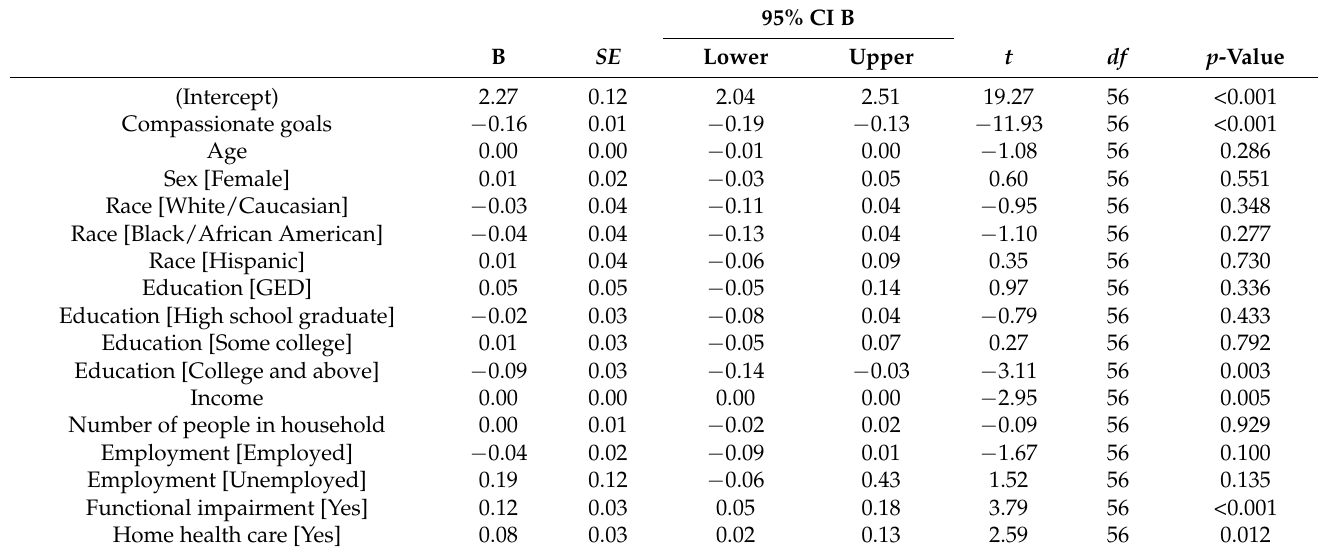
Table 3. Complex Samples General Linear Model with Compassionate Goals Predicting Loneliness.